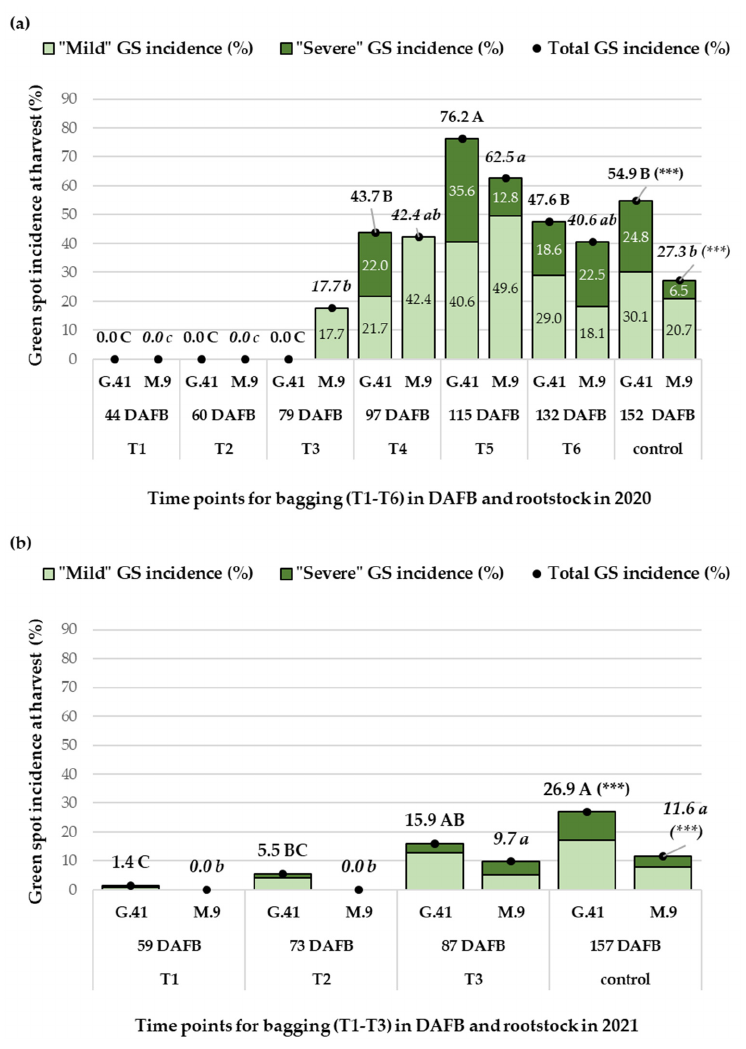
Figure 3. Green spot incidence at harvest by bagging time point and rootstock in ( a ) 2020; and ( b ) 2021. To facilitate the comparison between time points in the two seasons they are expressed in DAFB (for 2020: T1 = 44 DABF to T6 = 132 DAFB and for 2021: T1 = 59 DAFB and T3 = 87 DAFB). Light green shaded bars represent the proportion of “mild” GS, and dark green shaded bars represent the proportion of “severe” GS over the total incidence. Total incidence (%) in each treatment combination is cited above each bar and indicated by a round black marker. Separation of means are indicated by capital (‘G.41’) or lowercase italics (‘M.9’) letters within each rootstock and year, and the significance within each rootstock across time points (*** = p ≤ 0.001) is indicated in parentheses on the right side of the figure.